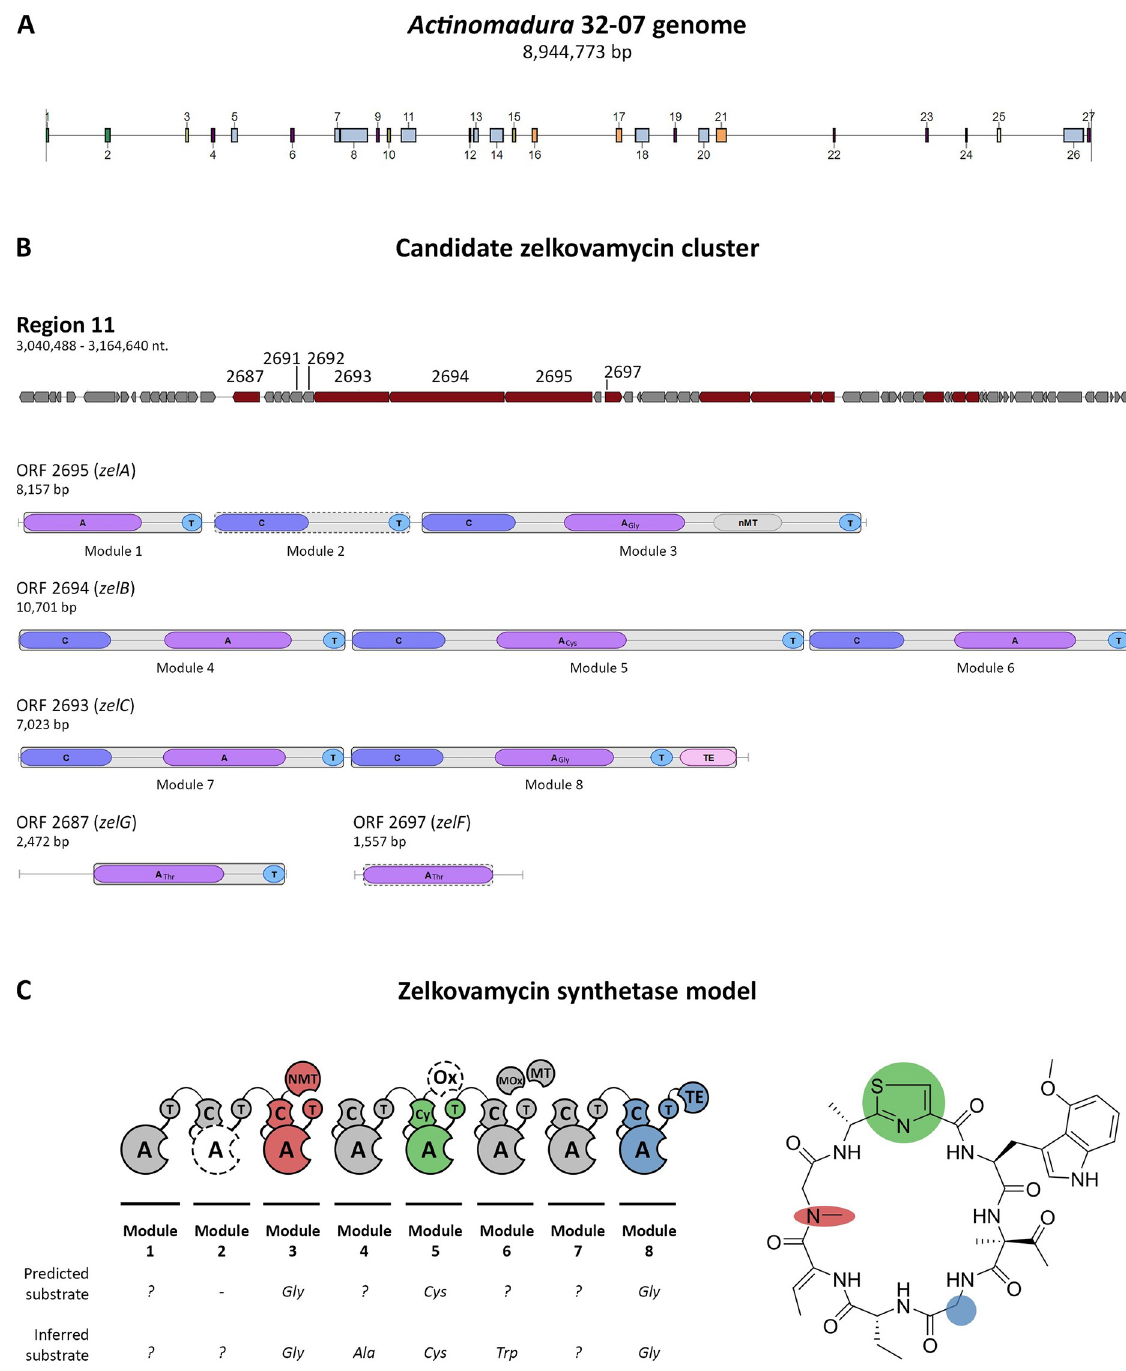
Fig 3. Selected results of the antiSMASH analysis on the genome of Actinomadura sp. 32–07. (A) A total of 27 regions were identified that contained one or more predicted biosynthetic clusters. (B) Of all the results, only region 11 (124,153 bp) contained a gene cluster coding for NRPS modules whose arrangement and domain composition agreed with the chemical structure of zelkovamycin ( zelA–C ). The core biosynthetic clusters in the region are highlighted in red and ORFs are numbered according to their position in the genome. Where available, the modules and domains coded by the ORFs of interest and their predicted substrate specificity are shown. (C) Schematic of the organization of the putative zelkovamycin synthetase according to the structure of zelkovamycin. The similarities between the expected residue specificity of some A domains and the respective software prediction are illustrated, along with the domains missing from the software prediction.